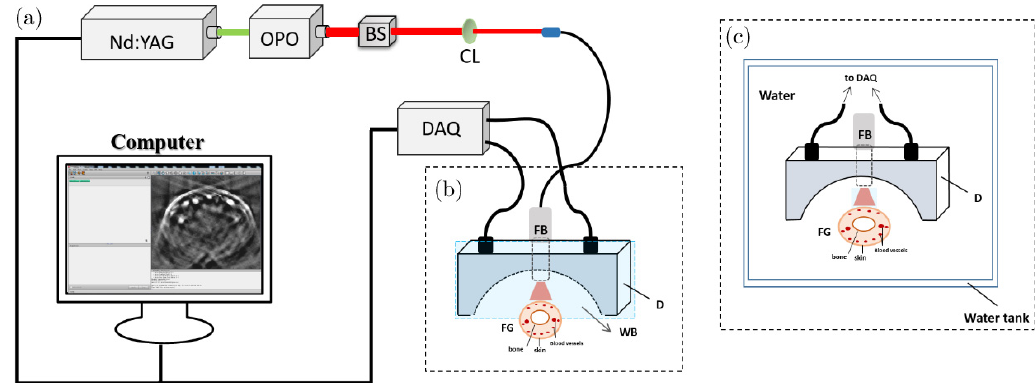
Fig. 1. (a) Multichannel photoacoustic imaging system. (b) Setup of the dry coupling subsystem. (c) Setup of the water coupling subsystem. OPO: optical parametric oscillator, BS: beam splitter, CL: convex lens, FB: ¯ber bundle, D: detector, FG: ¯nger, WB: water